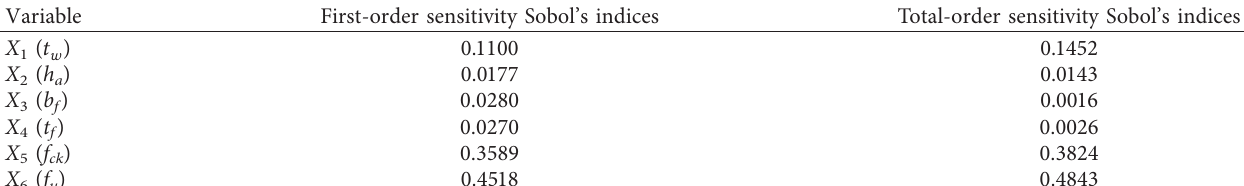
Table 10: Mean estimation with 200,000 Monte Carlo samples of the first and total Sobol’s indices the 50-year corroded SCC beams. Variable